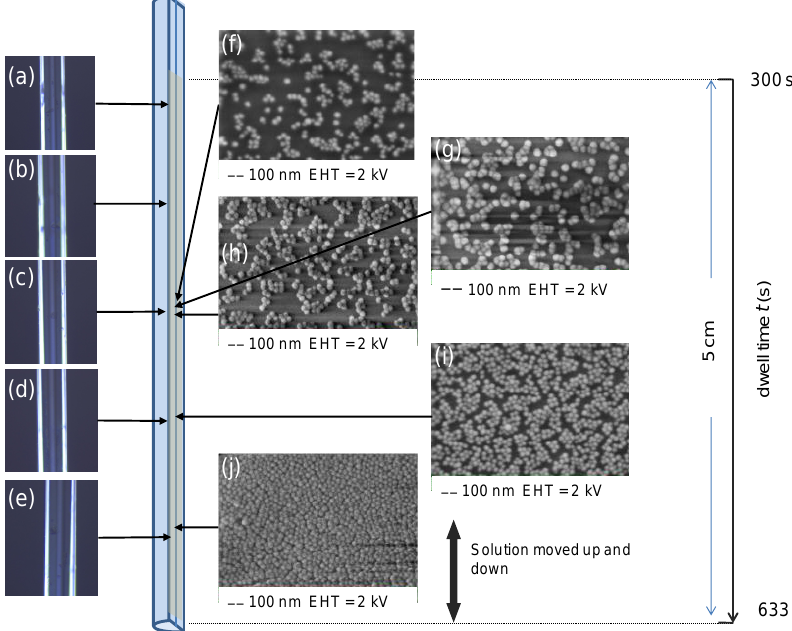
Figure 3. Vertical “dip-and-withdraw” deposition of nanoparticle layers: ( a ) stage v = 0.3 mm/s, t = 300 s (5 min); (SiO ) = 7.5 wt%. Optical microscope images on the left ( a – e ) 0 2 nano showing no clear sign of thick films (thin film interference is seen in Figure 4b with no cracking at this velocity). SEM analysis along the fibre (EHT = gun voltage), on the right ( f – j